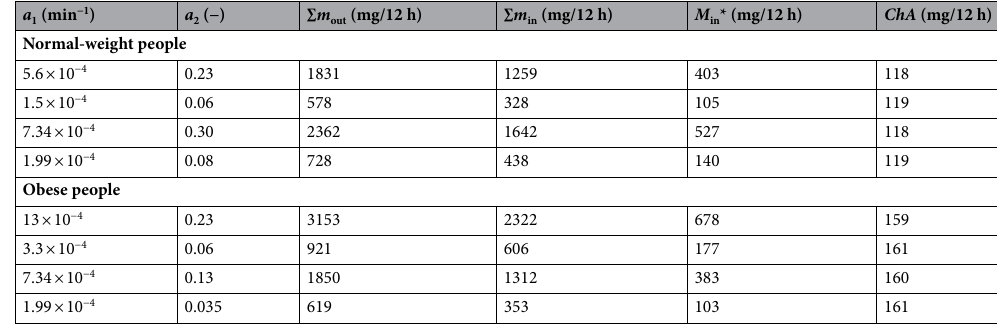
Table 1. Parameters a 1 and a 2 allow maintaining the concentration of total cholesterol around 180 mg/dL. The other parameters represent the values observed in 12 h: ∑ m out is the amount of cholesterol carried by bile from the liver; ∑ m in is the amount of cholesterol returning to the liver which is unrelated to bile ejected from the gall bladder; M in* is the mass of cholesterol returning to the liver along with bile after gall bladder contraction; and ChA is the mass of de novo-synthesized ChA from cholesterol